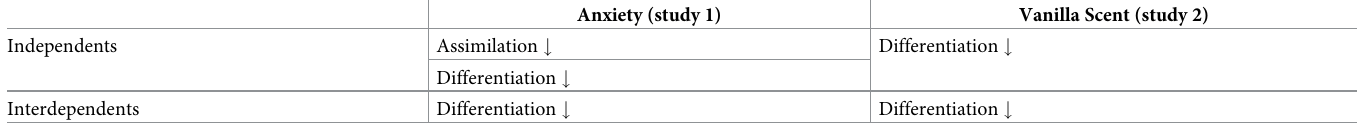
Table 5. Summary of results of Study 1 &